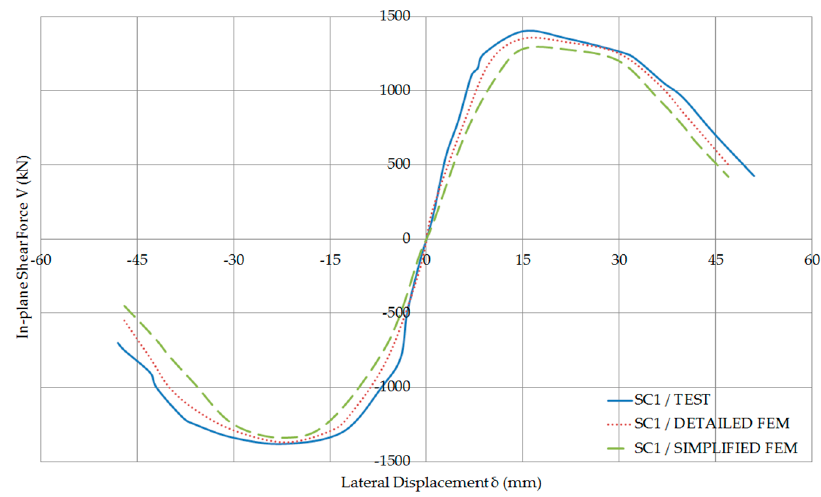
Figure 11. In-plane shear force—Lateral displacement Curves of SC1.